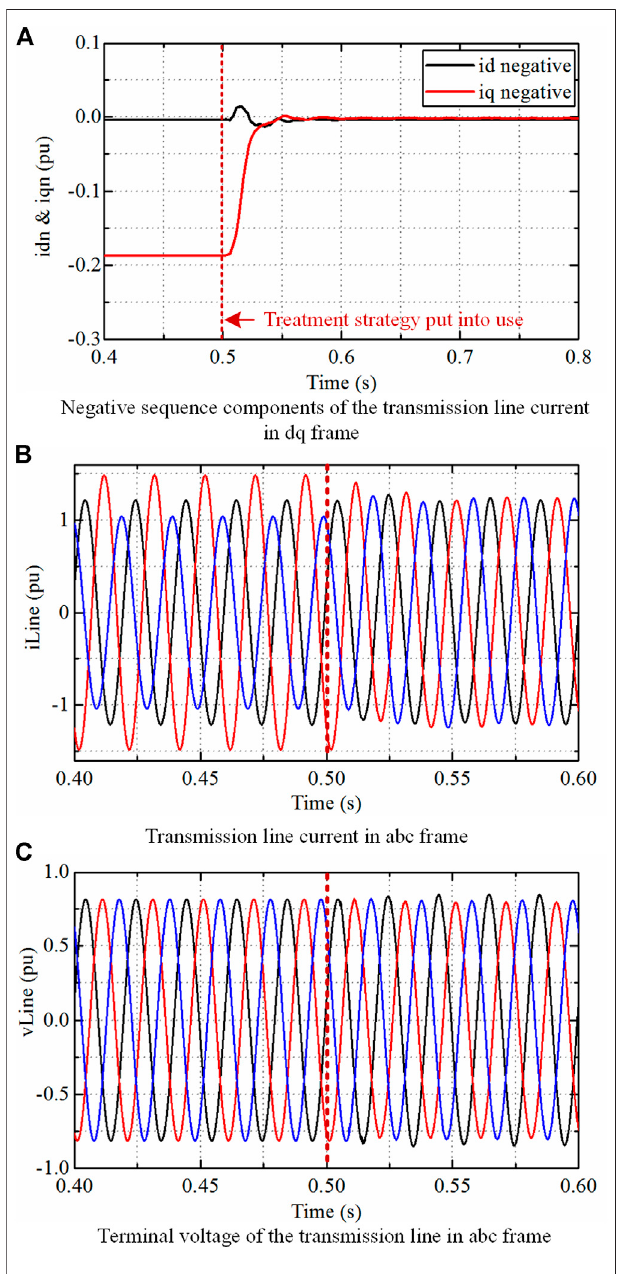
FIGURE 10 | Treatment strategy performance under unbalanced grid voltage